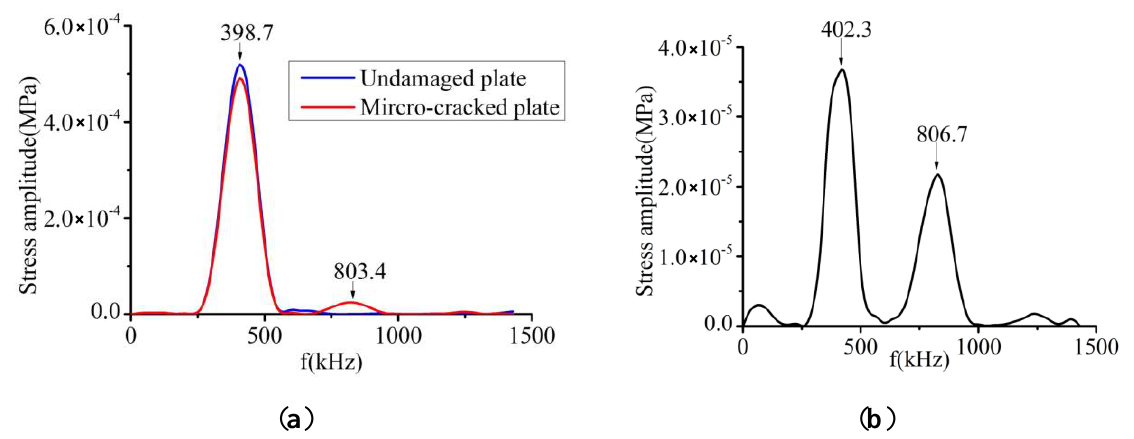
Figure 11. ( a ) Frequency spectra of S0 mode wave signals. The blue curve represents the Fourier spectrum of the S0 mode wave signal from the undamaged plate, and the red curve shows the Fourier spectrum of the S0 mode wave signal from the plate with a micro-crack 6 nm wide and 800 μm long. ( b ) Fourier spectrum of the new wave-packet signal from the damaged